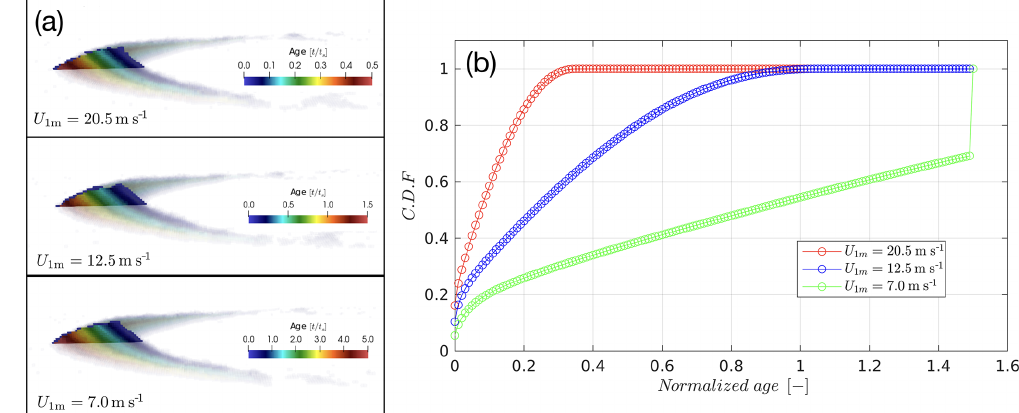
Figure 7. Distribution of age within a mobile barchan (case C24) prior to sintering. (a) Three panels show the distribution of age in the central slice as well as the arms of the barchan for the three different wind scenarios. (b) Cumulative distribution function of the age of the entire barchan for the three different wind scenarios.